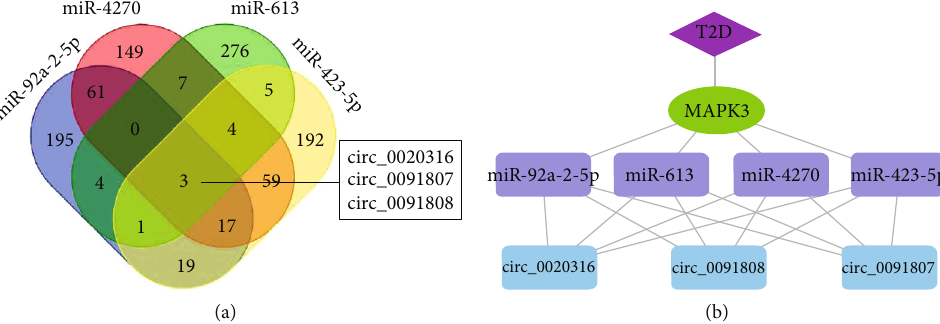
Figure 5: Prediction of upstream circRNAs orchestrating MAPK3 by online database. (a) Venn analysis of the upstream circRNAs of miR- 4270, miR-92a-2-5p, miR-423-5p, and miR-613 predicted by circBank database. (b) Construction of circRNA-miRNA-MAPK3 coexpression regulatory network by Cytoscape.